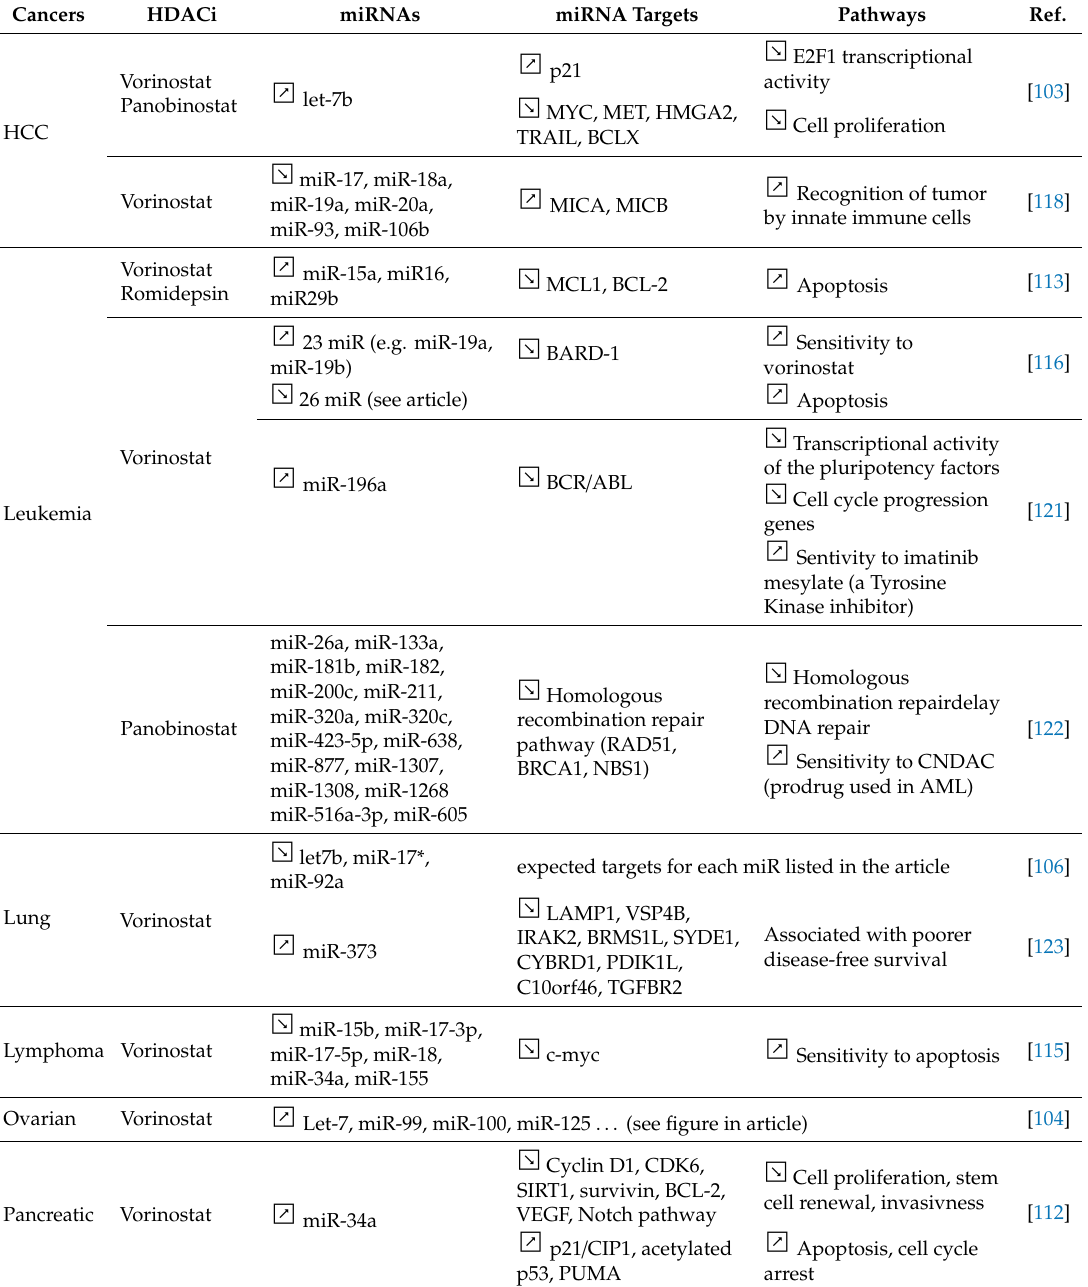
CRKL: v-crk avian sarcoma virus CT10 oncogene homolog-like, NF-kB: nuclear factor of kappa light polypeptide gene enhancer in B-cells 1, ITGA5: integrin, alpha 5, SEPHS1: selenophosphate synthetase 1, RSBN1: round spermatid basic protein 1, TFDP1: transcription factor Dp-1, BMI1: BMI1 proto-oncogene, polycomb ring finger, EZH2: enhancer of zeste 2 polycomb repressive complex 2 subunit, PTEN: phosphatase and tensin homolog, E2F: Table 4. microRNAs regulated by the four FDA-approved histone deacetylase inhibitors in Colorectal region, ABL: ABL proto-oncogene 1, non-receptor tyrosine kinase, RAD51: RAD51 recombinase, BRCA1: breast cancer 1, early onset, NBS1: nibrin, LAMP1: lysosomal-associated membrane protein 1, IRAK2: interleukin-1 receptor-associated kinase 2, BRMS1L: breast cancer metastasis-suppressor 1-like, SYDE1: synapse defective 1, Rho GTPase, homolog 1, CYBRD1: cytochrome b reductase 1, PDIK1L: PDLIM1 interacting kinase 1 like, TGFBR2: transforming growth factor, beta receptor II, CDK6: cyclin-dependent kinase 6, SIRT1: sirtuin 1, VEGF: vascular endothelial growth factor A, PUMA: BCL2 binding component 3. Arrows indicate decrease (